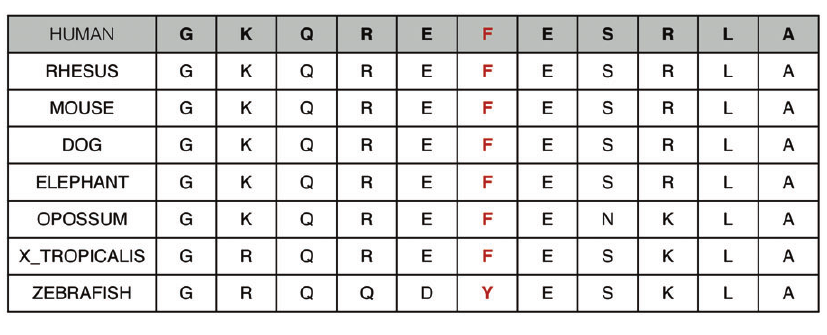
Figure 5. Conservation of the mutated amino acid Phe237Ser whose location is denoted in red color. Sequences are aligned according to University of California, Santa Cruz (UCSC) Genome Browser Vertebrate Multiz Alignment &